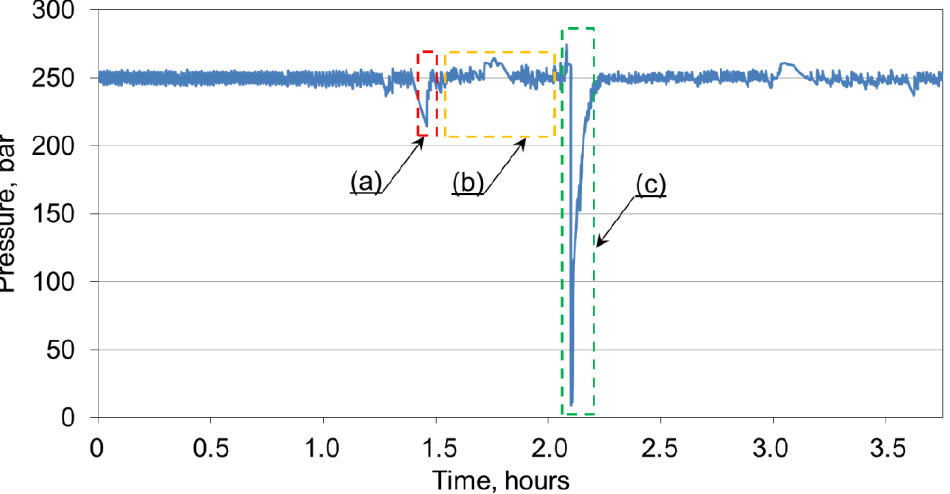
Figure 10. Testing the charging function along with the section relocation.